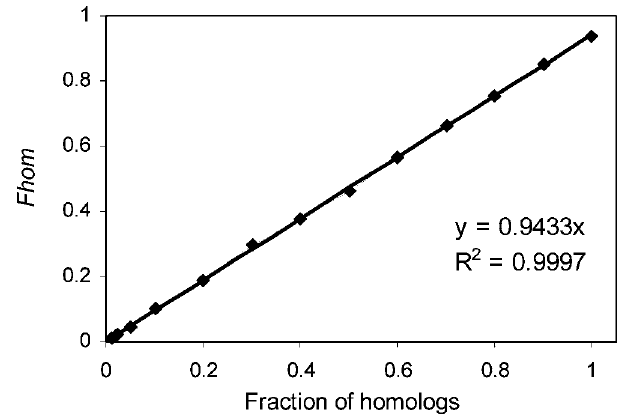
Figure 3. Robustness of the FhomEstimator. Fhom was estimated to be 94% for HomoloGene human/mouse pairs. Next, random protein pairs were added according to the original signal peptide prevalence of these organisms. A linear regression curve and the coefficient of determination (R 2 ) confirm that the Fhom Estimator has a wide dynamic range, and is robust to variation in signal-to-noise ratio.